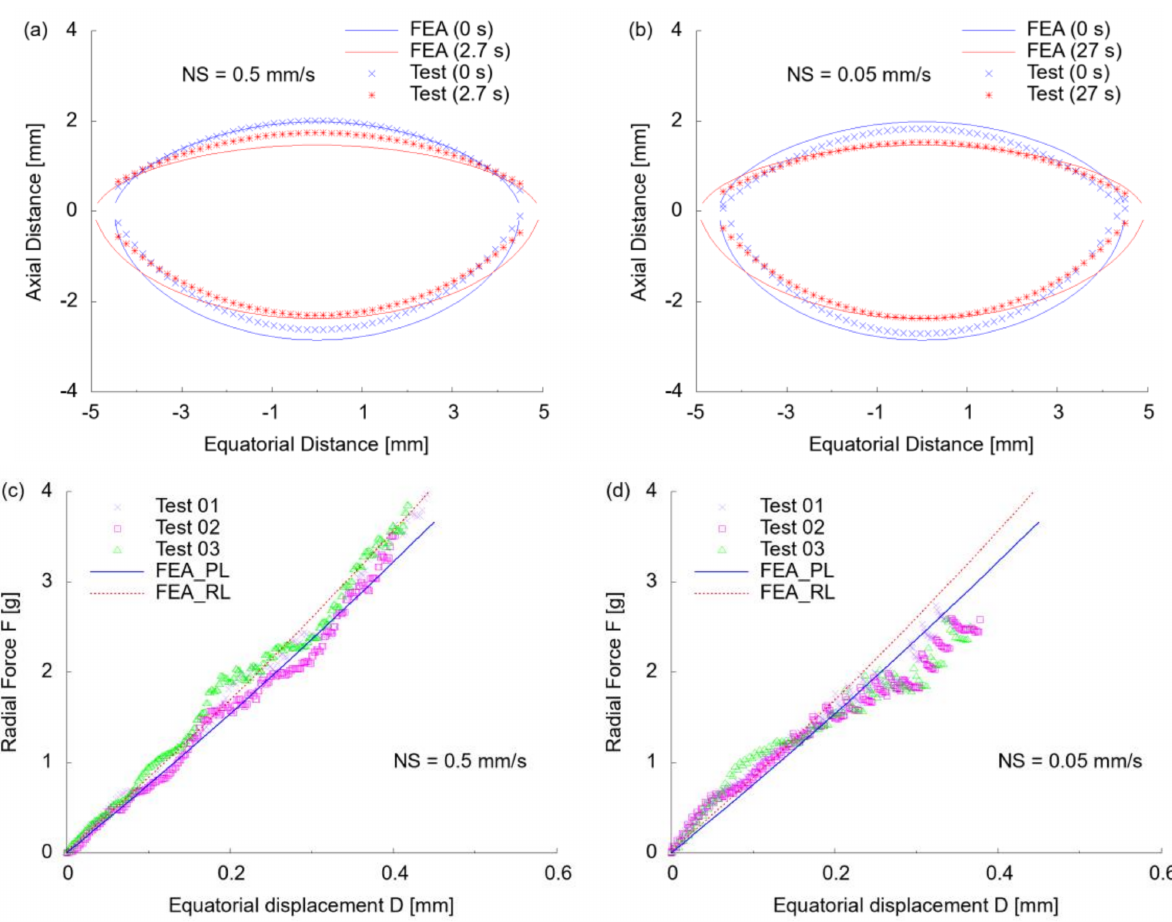
Figure 10. Comparison of profile and reaction force of ALC between experiment and FEA modelling: ( a ) change of profile at high speed (NS = 0.5 mm/s); ( b ) change of profile at low speed (NS = 0.05 mm/s); ( c ) radial stretching force at high speed (NS = 0.5 mm/s); ( d ) radial stretching force at low speed (NS = 0.05